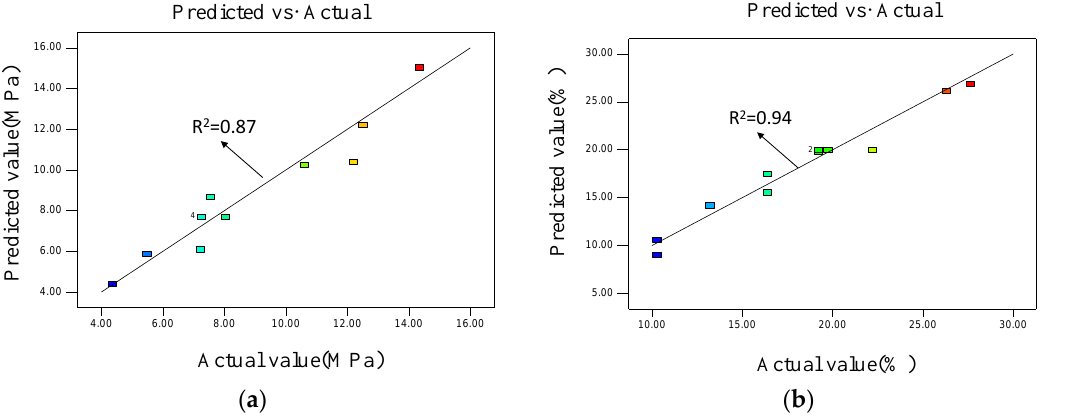
Figure 5. Predicted ( a ) compressive strength and ( b ) adsorption rate values of the phosphorous gypsum based on the water – paste ratio and the air-entraining agent interaction.